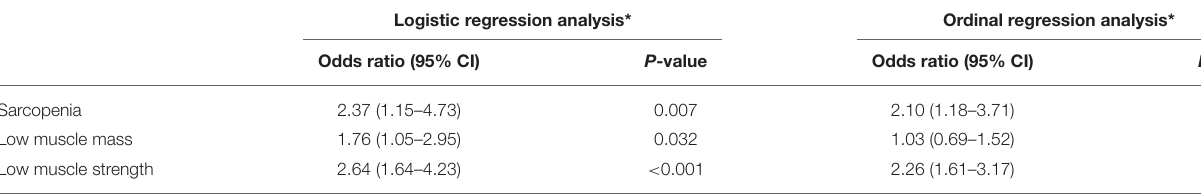
TABLE 3 | Multivariable analysis for the association between sarcopenia and functional outcomes 90 days after discharge.